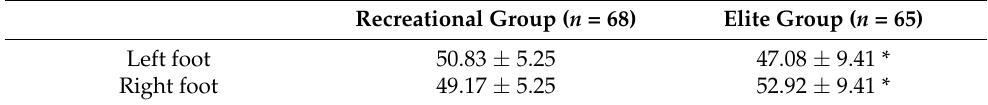
Table 5. Centers of gravity balance assessment under static standing in elite badminton players.